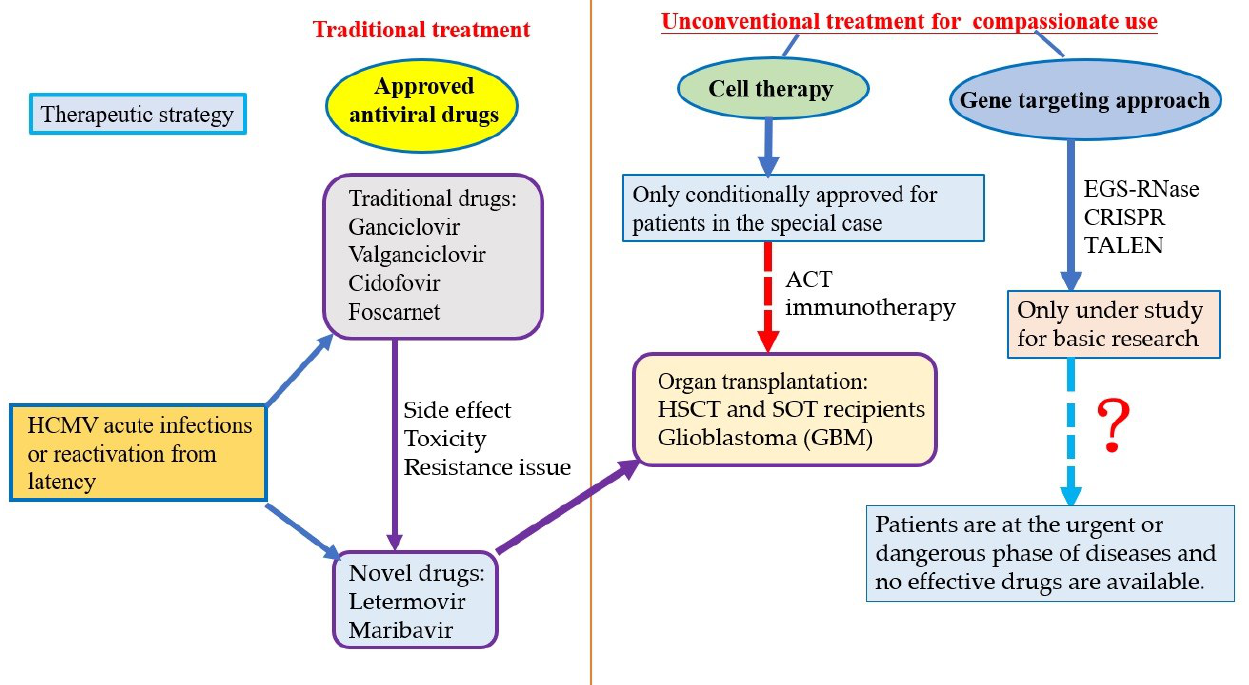
Figure 2. A feasible process using different strategies for the effective treatment of HCMV infections .